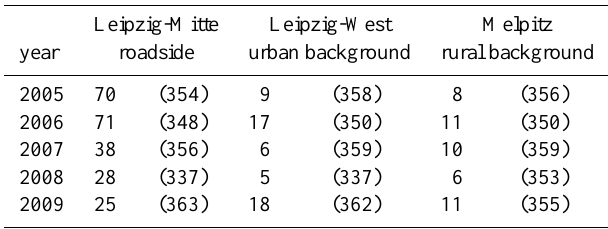
Table 1. Average PM 10 and PM 2 . 5 particle mass concentrations over the five year period of this study ( µ ), in µgm − 3 . The Table includes the standard deviations of the mean ( σ µ ).